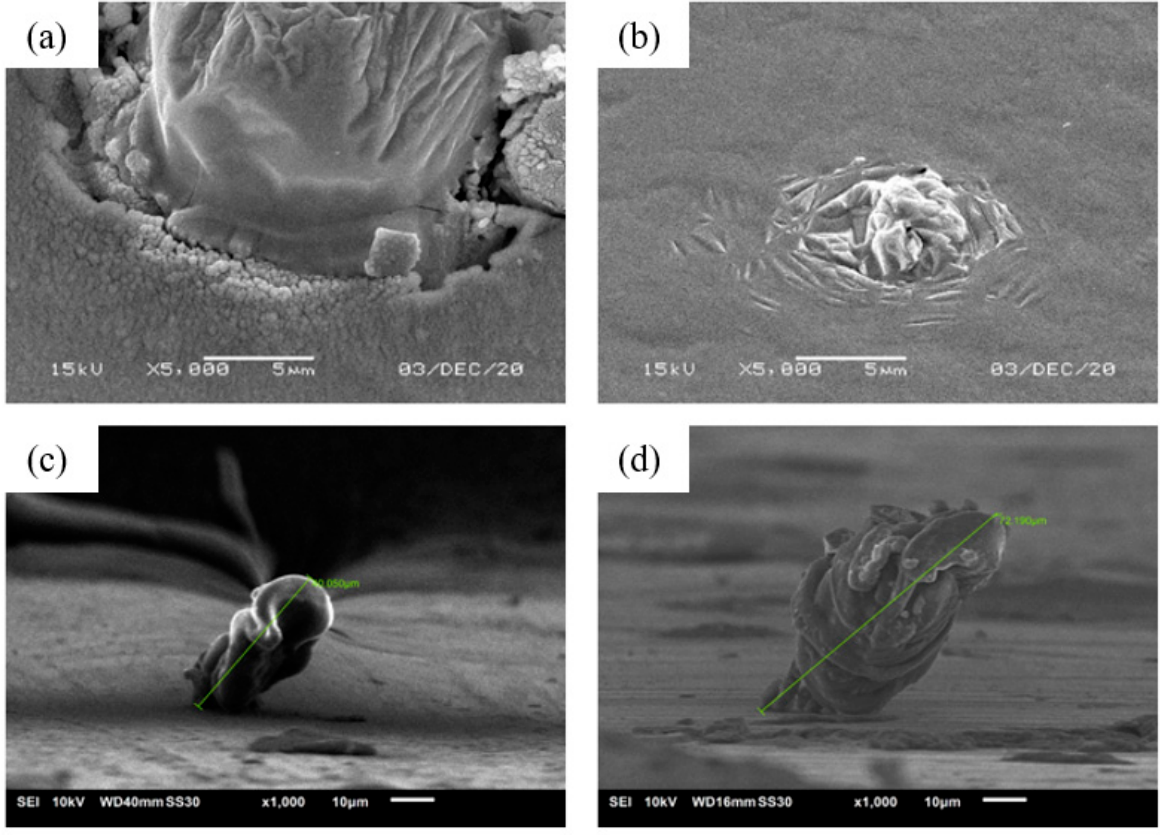
Figure 12. Different types of whiskers growing from Sn-based : ( a ) Sn whiskers formed from the crack region, ( b ) Sn whisker growth from compressive stress around it, ( c , d ) JEDEC measuring of irregular shape of whisker.